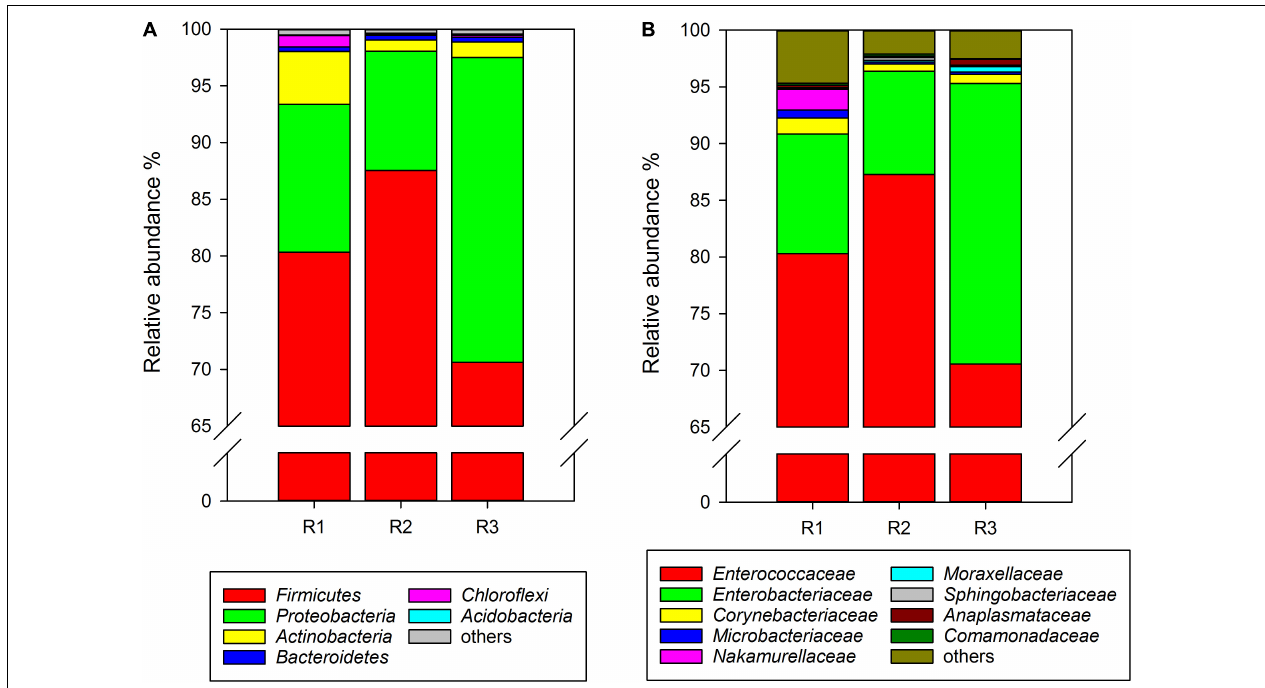
FIGURE 1 | Relative abundance of the gut microbiota from rice-feeding C. medinalis for three generations at the phylum (A) and family (B) levels. R1–R3: the first to third-generation of C. medinalis fed on rice.